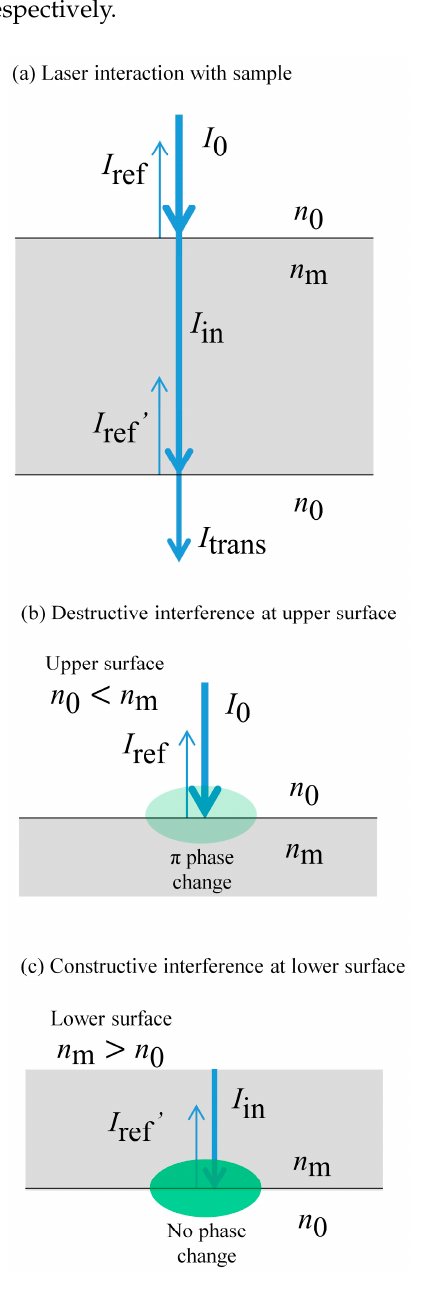
Figure 8. Schematic of the mechanism of interference at both surfaces (light ray is shown at an angle for illustration) showing ( a ) laser interaction with the sample; ( b ) destructive interference at the upper surface and ( c ) constructive interference at the lower surface.